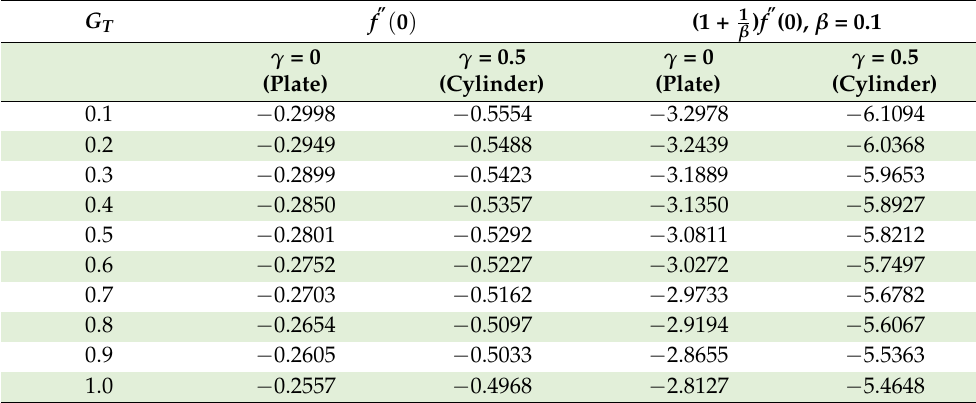
Table 1. Impact of G T parameter on skin friction coefficient.